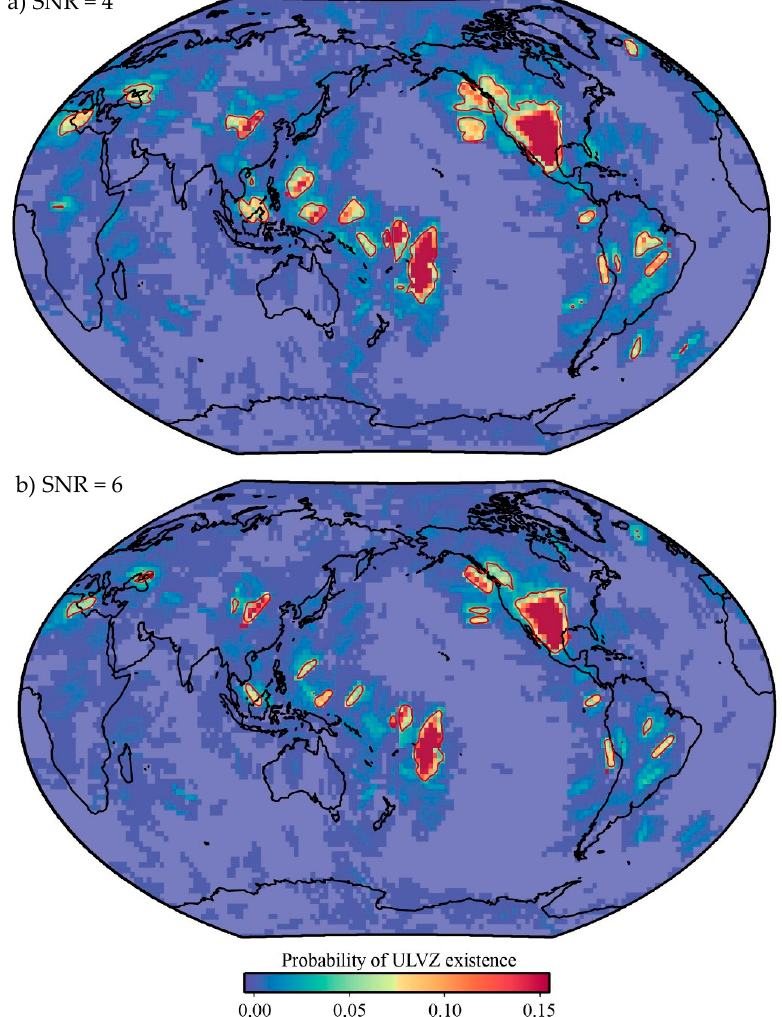
Figure 8. For each 2 ◦ × 2 ◦ grid cell, we plot the mean of the posterior probability density for ULVZ existence. Two cases are shown for signal-to-noise (SNR) ratios of ( a ) SNR = 4, and ( b ) SNR = 6. As an approximate guide to where the highest probabilities exist, we have drawn a contour around the 0.04 probability. The lightest purple color in the plot shows regions where we have no data